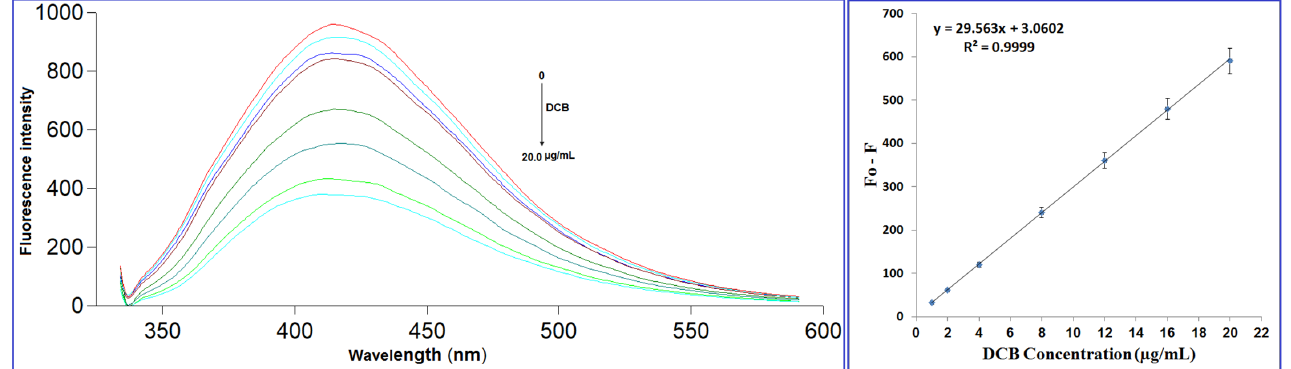
Figure 3. Fluorescence emission spectra of N-CQDs upon the addition of different concentrations of DCB (from top to bottom: 0, 1.0, 2.0, 4.0, 8.0, 12.0, 14.0, 16.0; 20.0 µg/mL).